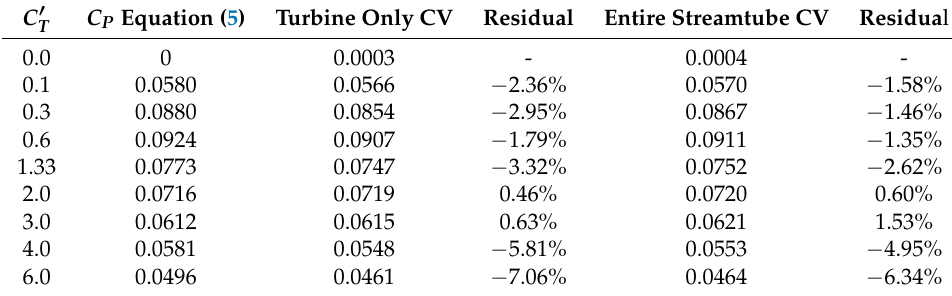
= 0, where C = 0 P T